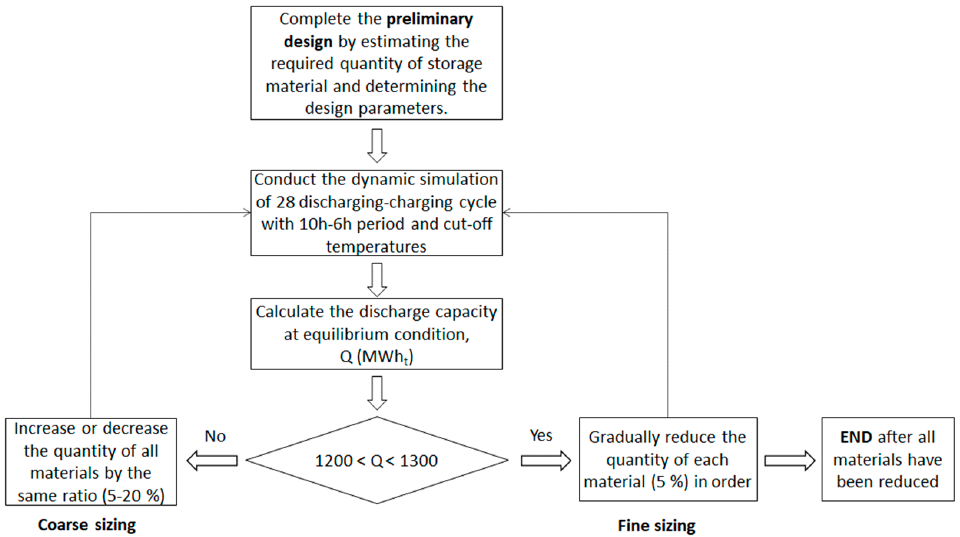
Figure 4. Flow chart of the design and sizing procedure.